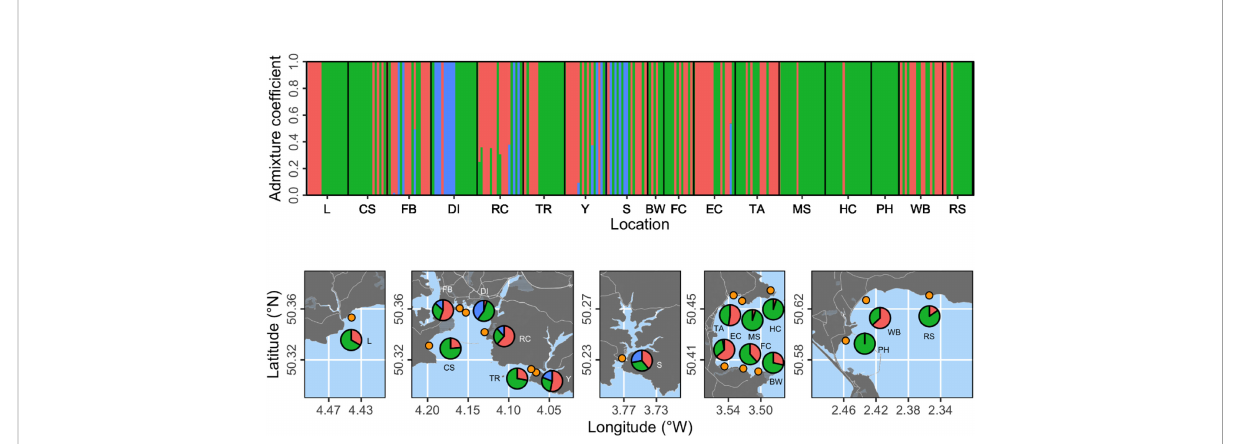
FIGURE 2 Population structure analysis based on three proposed genetic clusters. The top panel shows admixture coef fi cients indicating the probability of individual samples belonging to each of the three clusters (here shown as red, green, or blue). Bottom panels show location-level summaries of admixture coef fi cients at each of the 17 sampling locations (orange points).